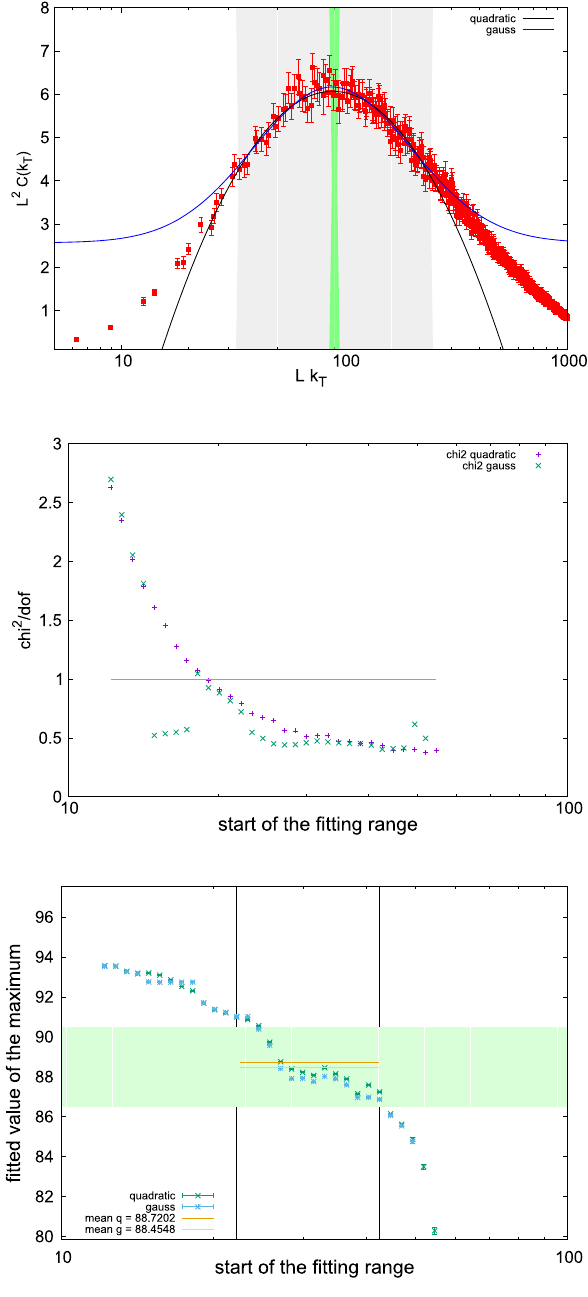
Fig. 5 Example of extracting the saturation scale Q s by fitting the maximum of the gluon distribution on a 512 × 512 lattice, at rapidity s = 0 . 04,evolvedinpositionspace.Thestatisticalerrorswereincreased by a factor 3 in order to account for the discretization effects. The upper panel shows the comparison of the quadratic and Gaussian fits with the green band being the 1- σ uncertainty of the saturation scale and the gray band showing the fitting range. The middle panel shows the value of χ 2 / dof as a function of the fitting range. The bottom panel shows the dependence of the extracted maximum on the fitting range for both employed fitting